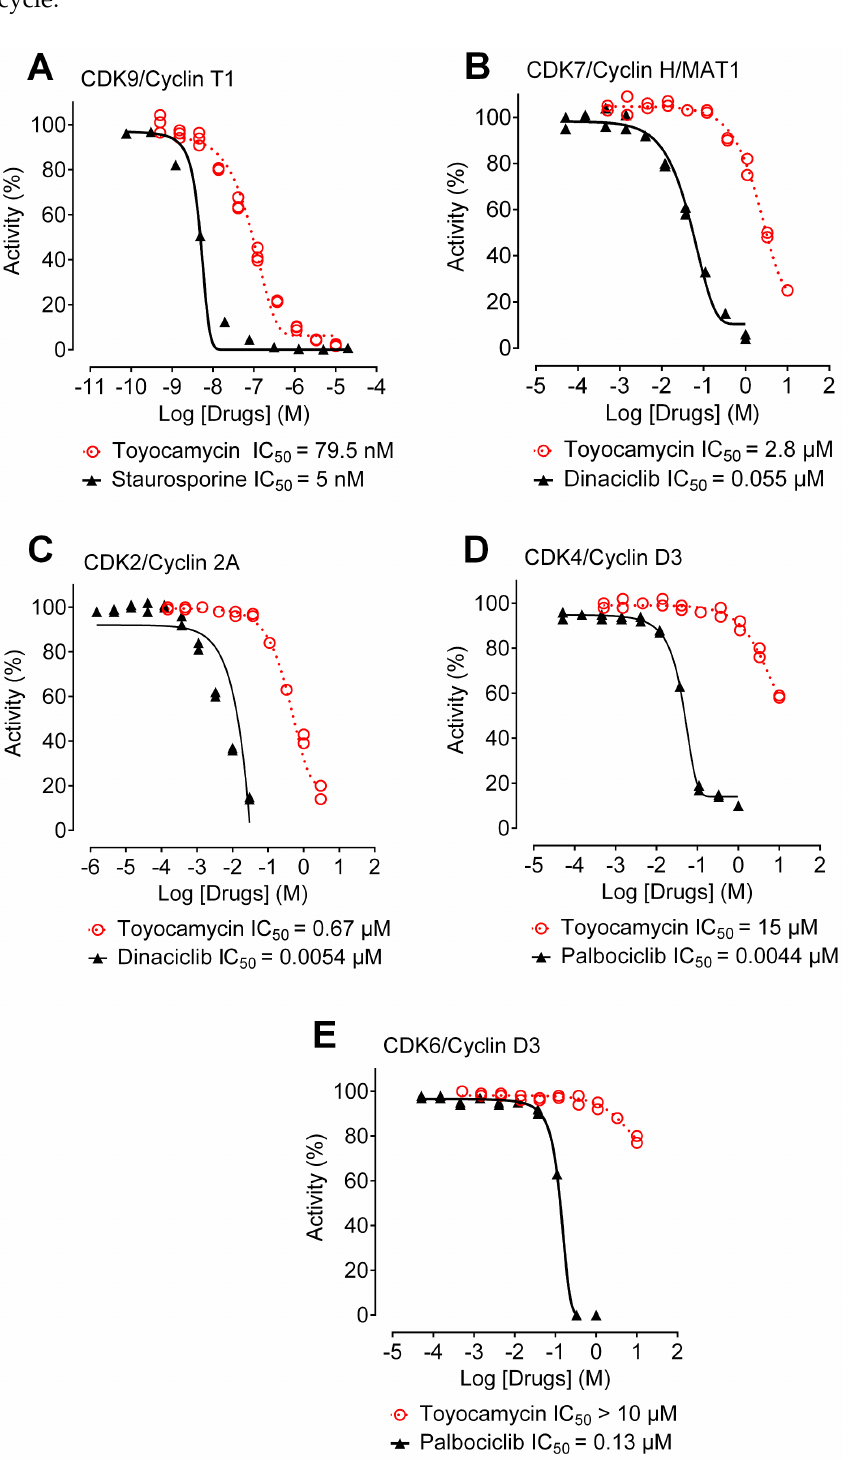
Figure 5. Toyocamycin is a potent and specific inhibitor of CDK9. Enzymatic assays were per- formed with toyocamycin at different concentrations against ( A ) CDK9/CyclinT1, ( B ) CDK7/Cyclin H/MAT1, ( C ) CDK2/Cyclin 2A, ( D ) CDK4/Cyclin D3, and ( E ) CDK6/Cyclin D3. Concentration producing 50% enzymatic inhibition (IC 50 ) was calculated for toyocamycin and other inhibitors listed in the